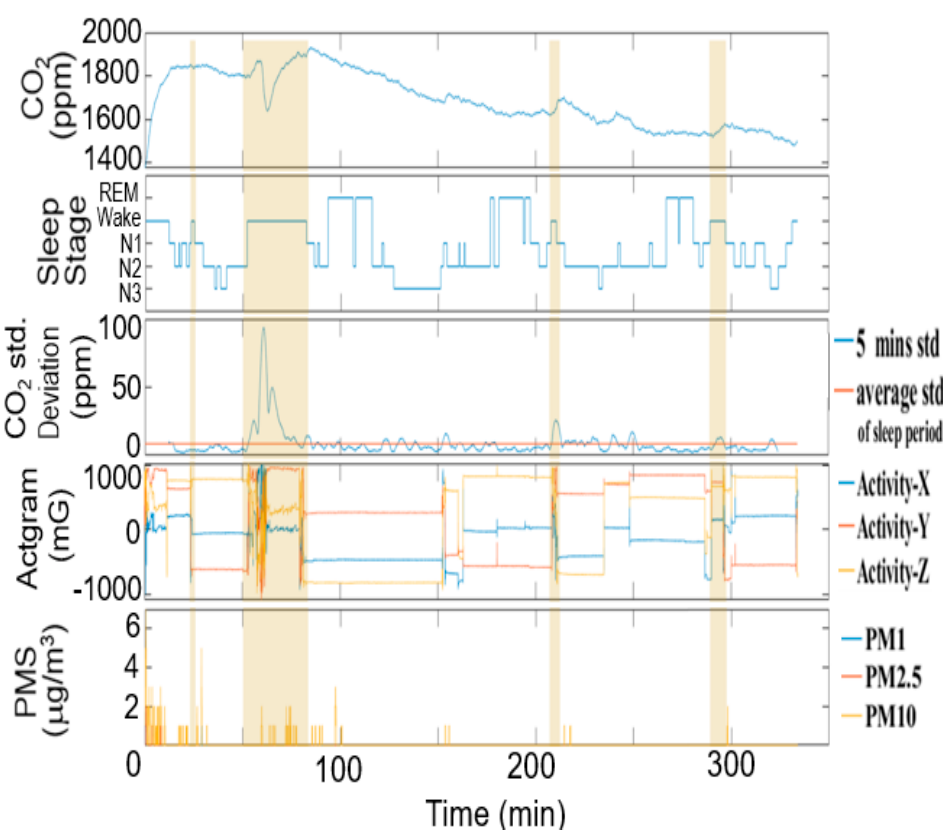
Figure 5. The sleep assessment experiment using the CAQLEA system. The CO 2 concentration, sleep stages obtained from PSG scoring, raw data of the activity watch and amounts of PMs were aligned and compared.